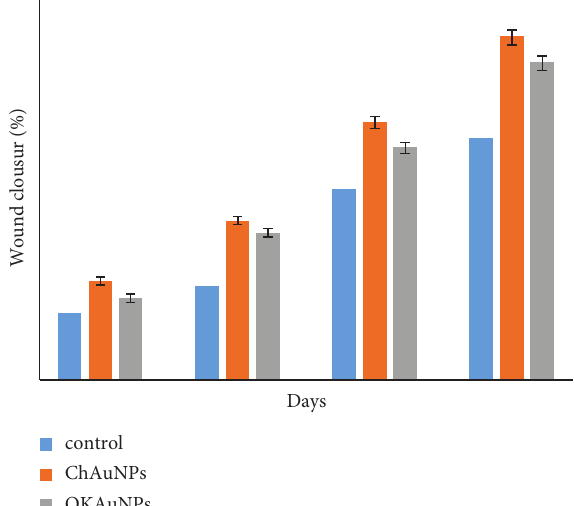
Figure 10: The percentage of wound closure for the control group, group Ch Au NPs, and group Ok Au NPs (mean ± SEM, n � 5). P < 0.05 is a significant level compared to the control group.